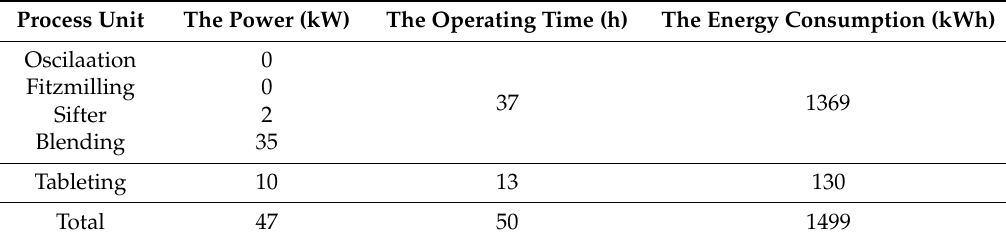
Table 2. Summary of manufacturing process units of the product per batch after improvement based on 2013 data.